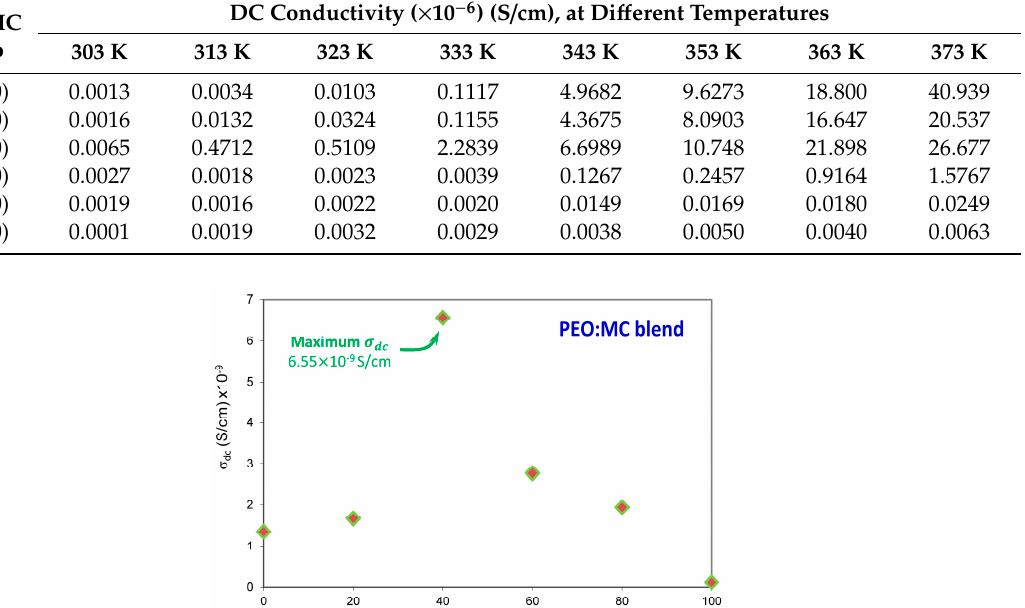
PEO:MC compositions.